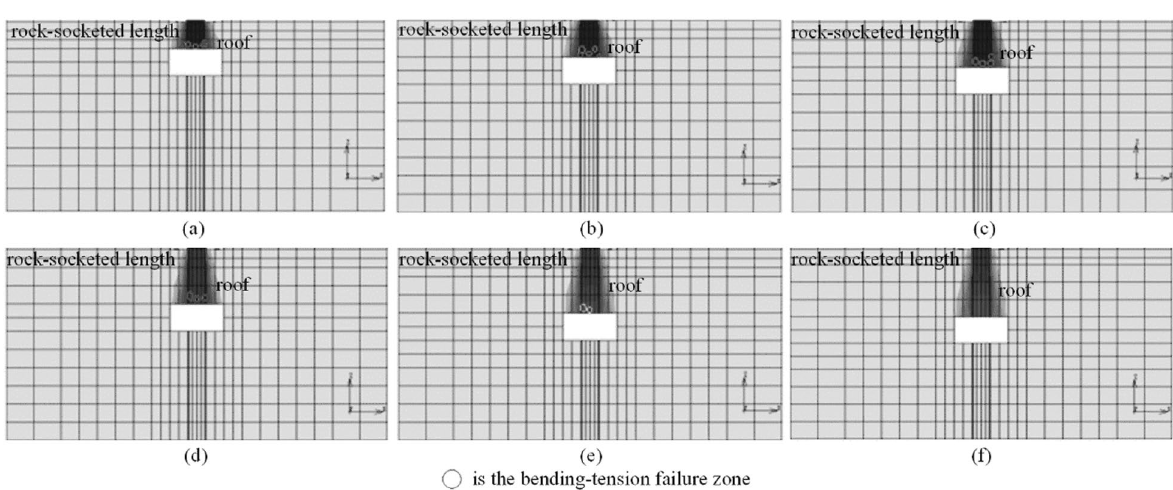
Figure 13. Ratios of tip resistance and side resistance of piles: ( a ) different cave height; ( b ) different cave span; ( c ) different roof thickness.